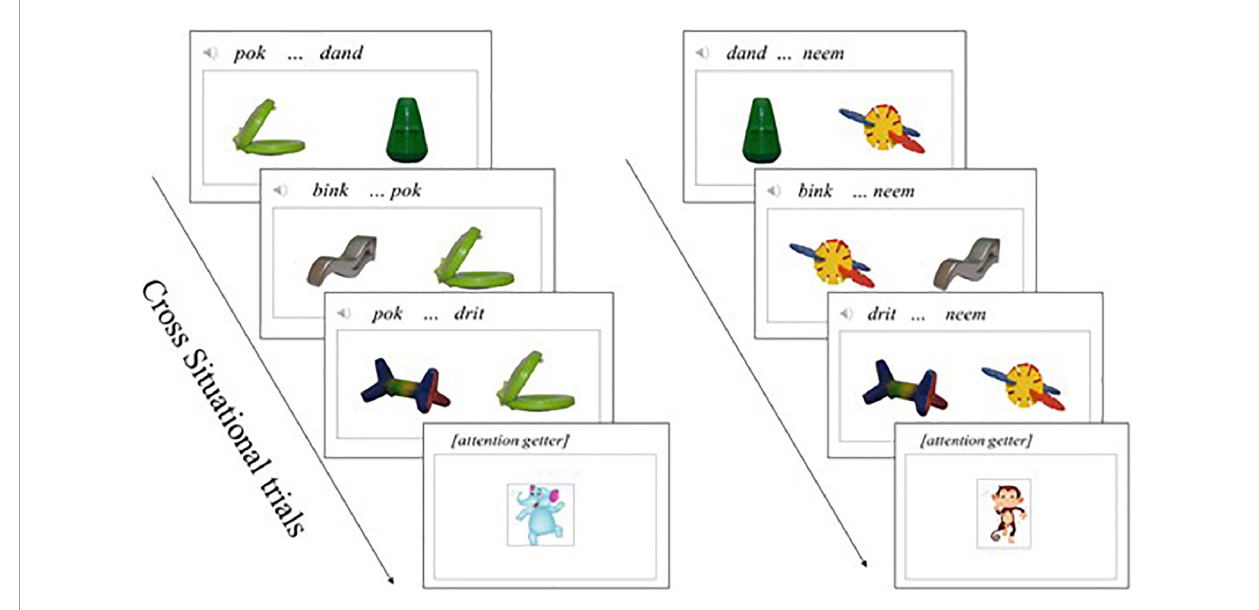
FIGURE3 Illustration of cross situational word learning